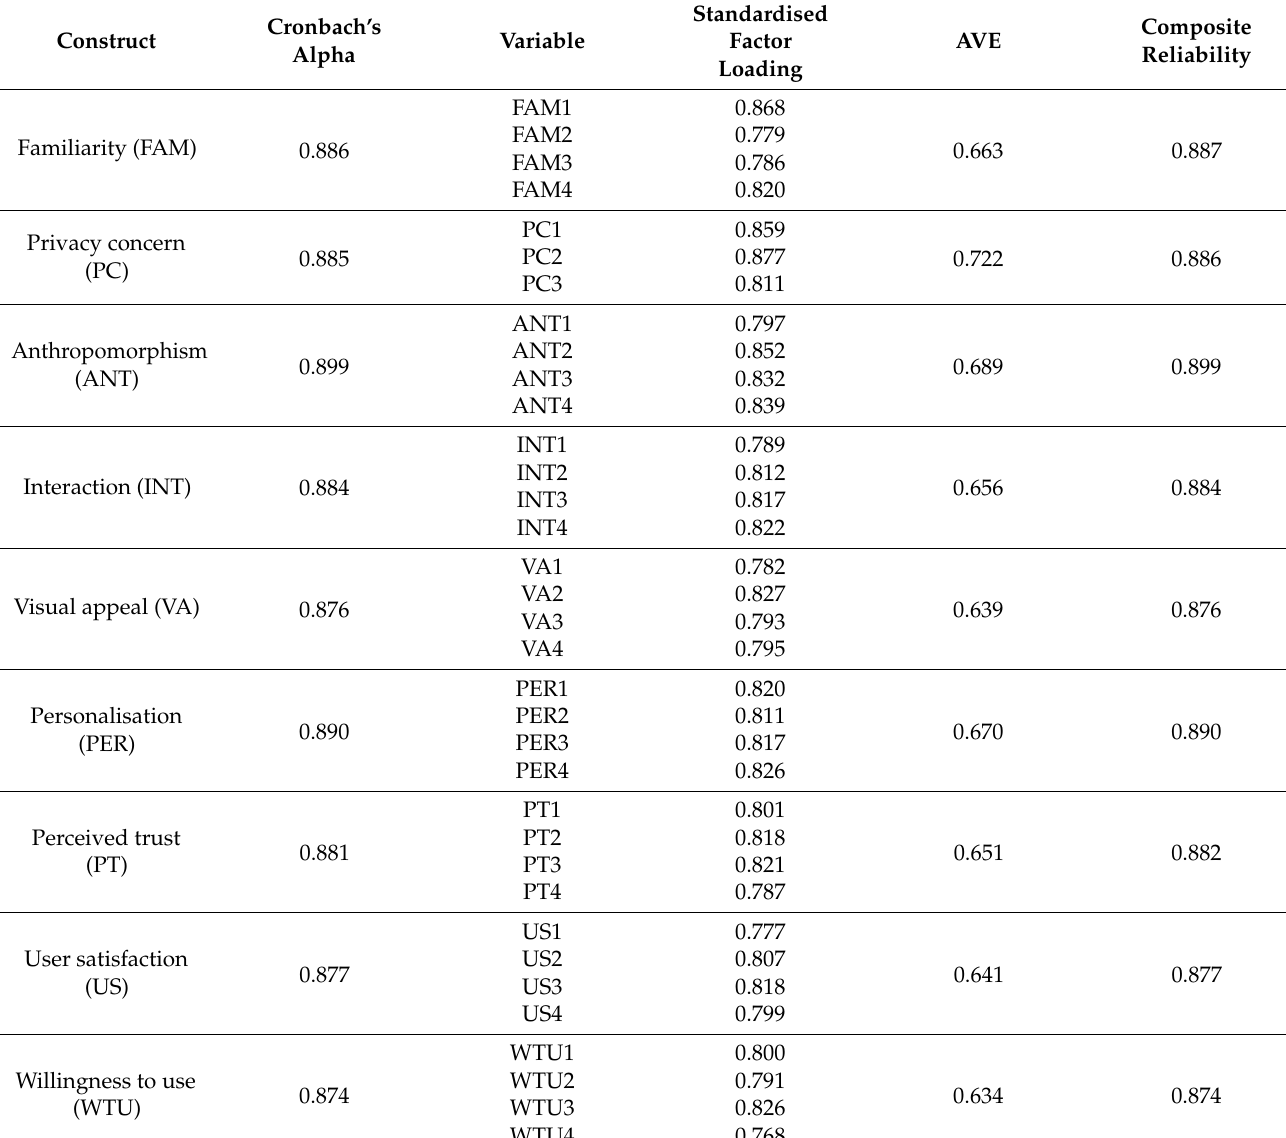
Table 3. Reliability and unidimensionality.